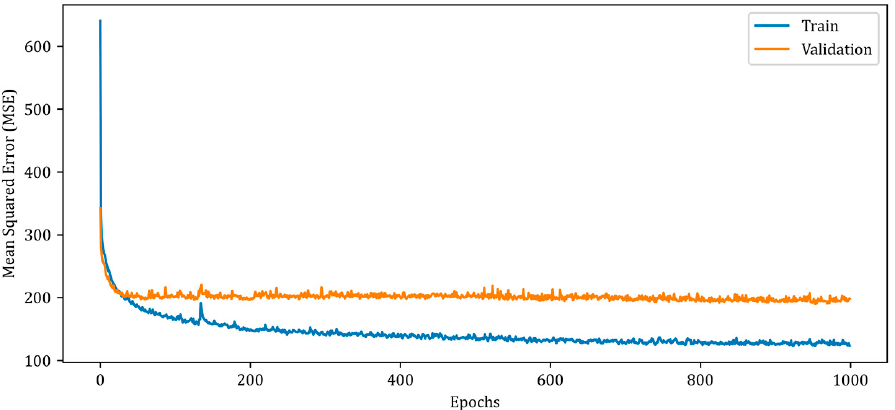
Figure 7. Mean squared error (MSE) curves for training and validation phases of the proposed RV-DNN model.